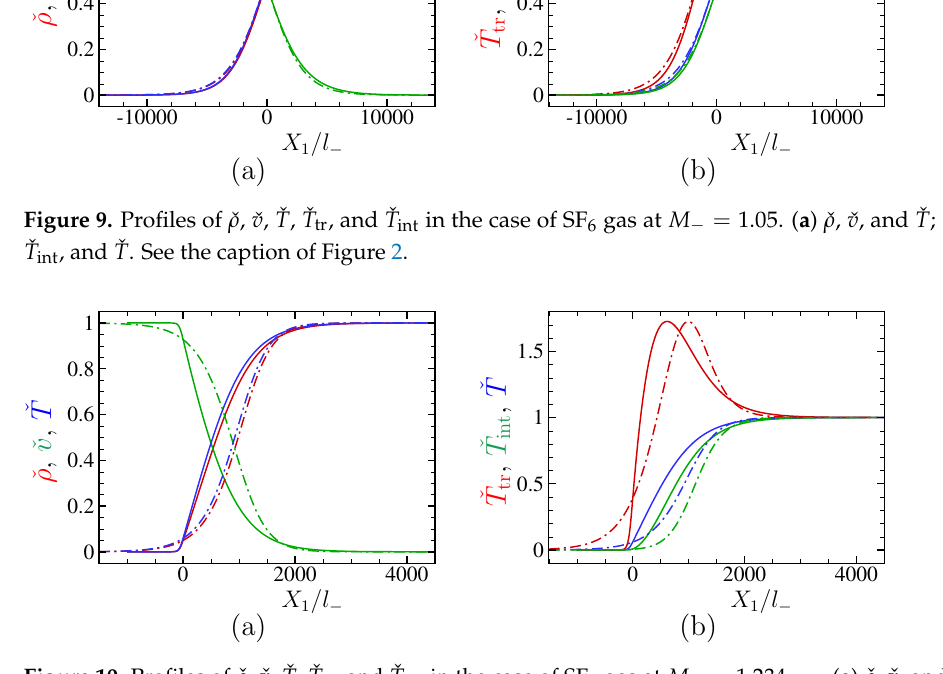
Figure 10. Profiles of ˇ ρ , ˇ v , ˇ T , ˇ T tr , and ˇ T int in the case of SF 6 gas at M − = 1.234 . . . . ( a ) ˇ ρ , ˇ v , and ˇ T ; ( b ) ˇ T ˇ T ˇ T . See the caption of Figure tr , int , and